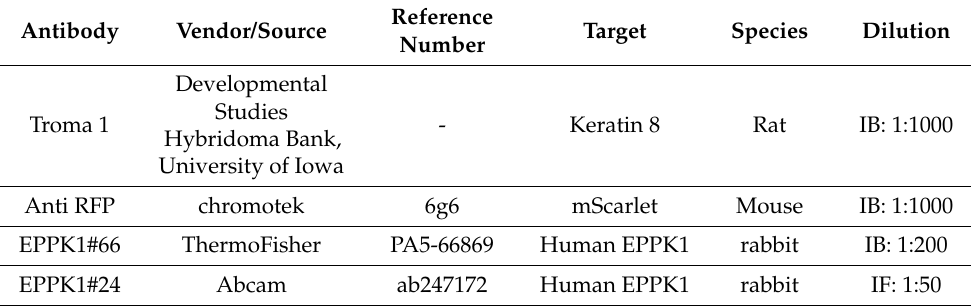
Table 2. Primary antibody used in this